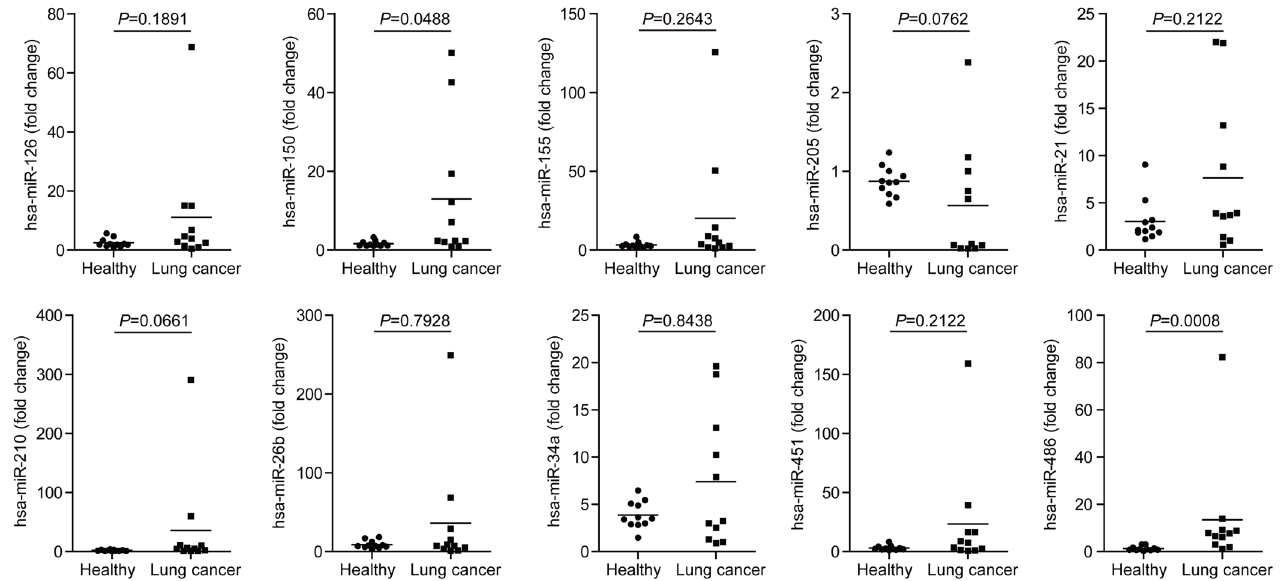
Fig 1. Plasma levels of ten miRNAs. Plasma levels of miR-126, miR-150, miR-155, miR-205, miR-21, miR-210, miR-26b, miR-34a, miR-451 and miR-486 in 11 healthy volunteers (Healthy) and 11 NSCLC patients were analyzed using qRT-PCR and normalized with cel-miR-39. Solid dots showed relative expression of miRNAs in each subject; transverse lines indicated means of miRNAs in each group.